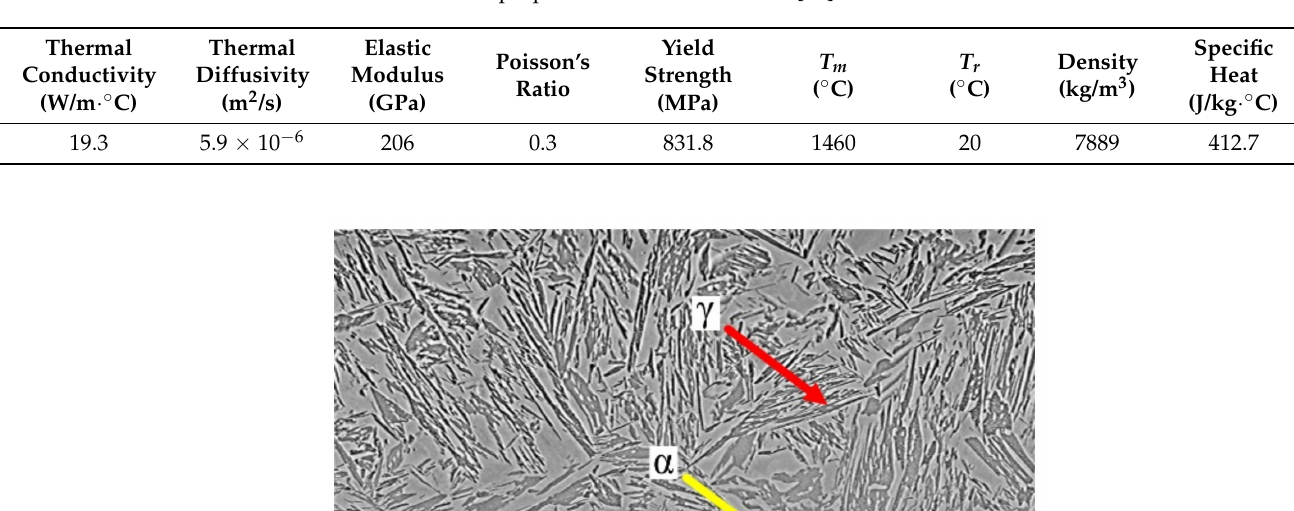
Table 2. Material properties of AerMet100 steel [30].